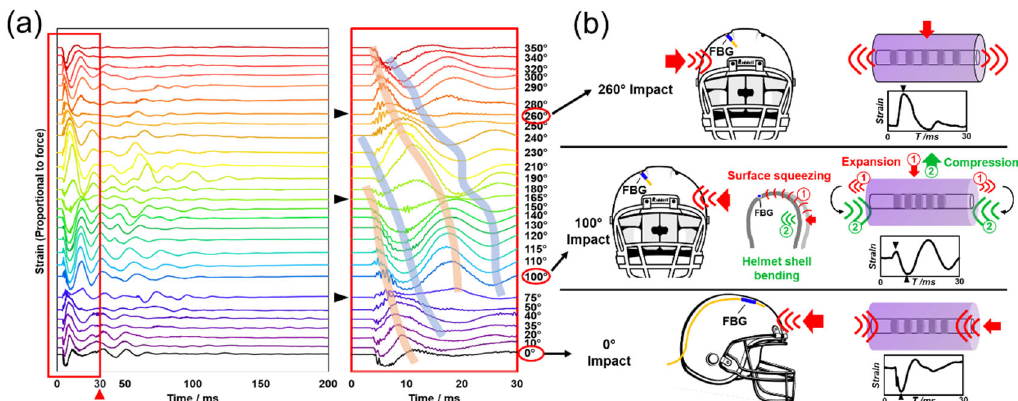
Figure 4. Stacked transient oscillatory signals and the physical interpretation illustrated by three selected impact directions. ( a ) A series of FBG spectra generated using 28 different impact directions and the same initial impact energy, 19.84 J. The full view of transient signals is shown on the left. The expanded view shown in the red box to the right displays the first 30 ms of data in greater detail. The black arrows indicate three peak/valley inflection points. Orange and blue bands illustrate the “tide-like” trends of the peaks and valleys. ( b ) Depictions of physical insights for three selected impact directions at 0°, 100° and 260°. Applied forces and their directions were schematically illustrated with either the front or side views of the helmet. The FBG sensor position is pinpointed by a short blue segment, and relative FBG expansions or compressions were demonstrated schematically on the right.